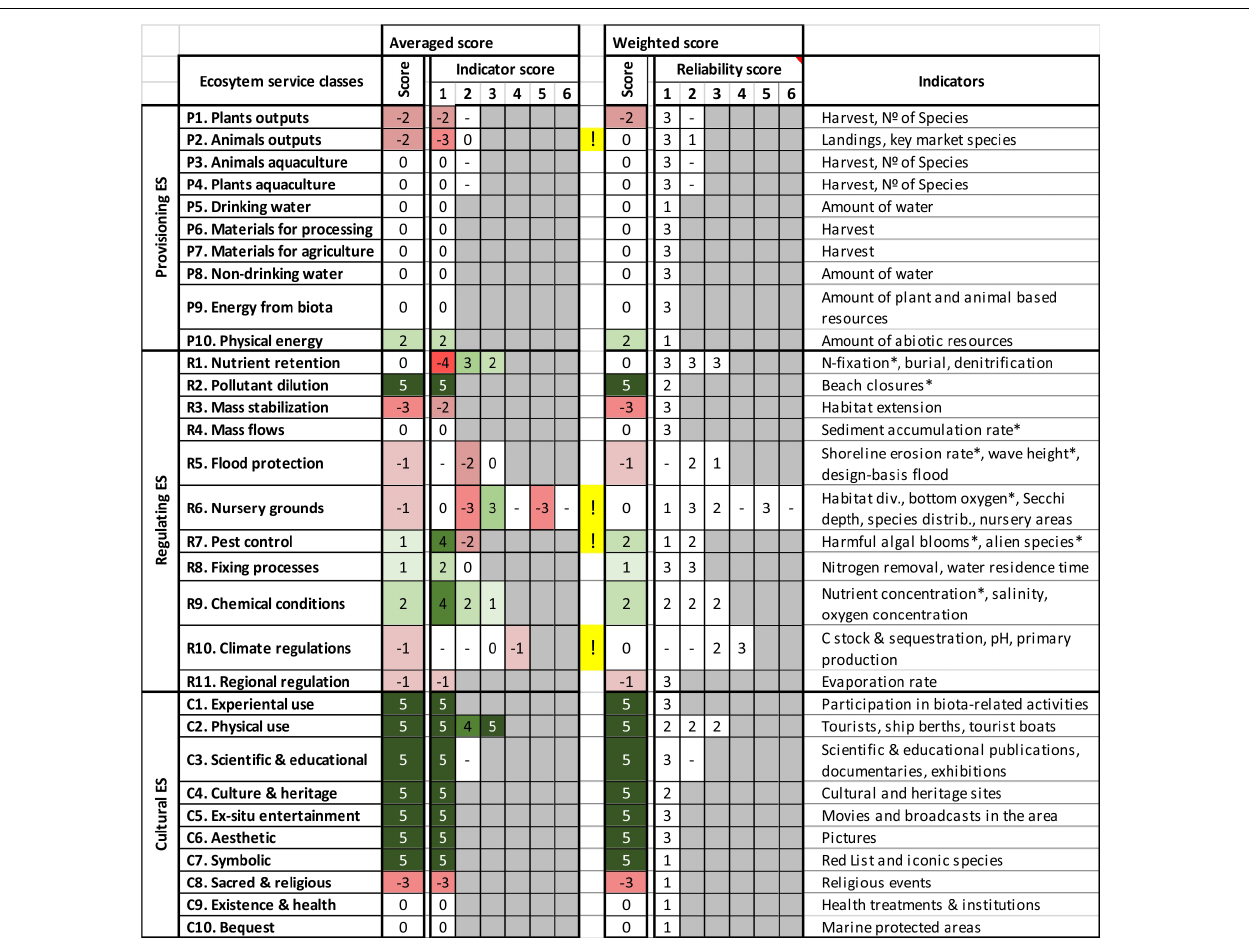
FIGURE 7 | Data based ES assessment for the entire Warnow Estuary provision. Shown are changes between 1960 (WFD good ecological status) and today. The scores for ES classes are calculated with two methods: by averaging and weighted averaging. The latter takes into account data reliability. Reliability scores indicate very high (1, weighting factor 2) to low (4, weighting factor 0.5) data quality. Positive ES class scores indicate an increase in ES provision today ( Figure 3 ). The asterisk ( ∗ ) points out indicators where a decrease in the value was interpreted in the sense of an increase in ES provision. The exclamation mark indicates ES classes where differences in scores